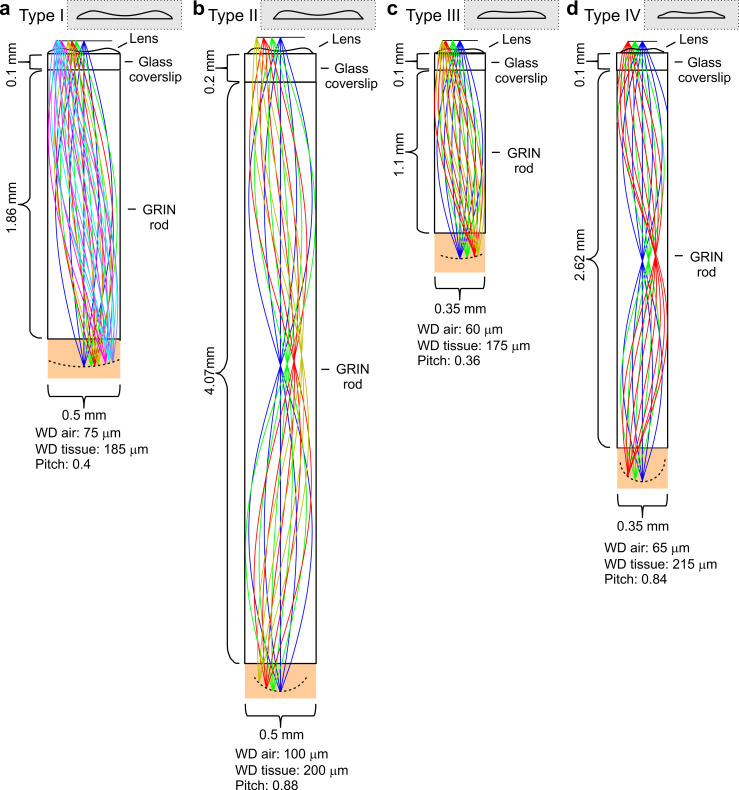
Optical design of eFOV-microendoscopes.(a-d) Ray-trace simulations for the four different eFOV-microendoscopes (type I-IV). The insets show the profiles of corrective polymeric lenses used in the different eFOV-microendoscopes. For each eFOV-microendoscope, it is specified the thickness of the coverslip, the length, the diameter of the GRIN rod, the pitch of the GRIN rod, and the working distance, in air or in tissue, at which the simulated correction of aberrations was performed. See also Supplementary file 1 - Table 1.